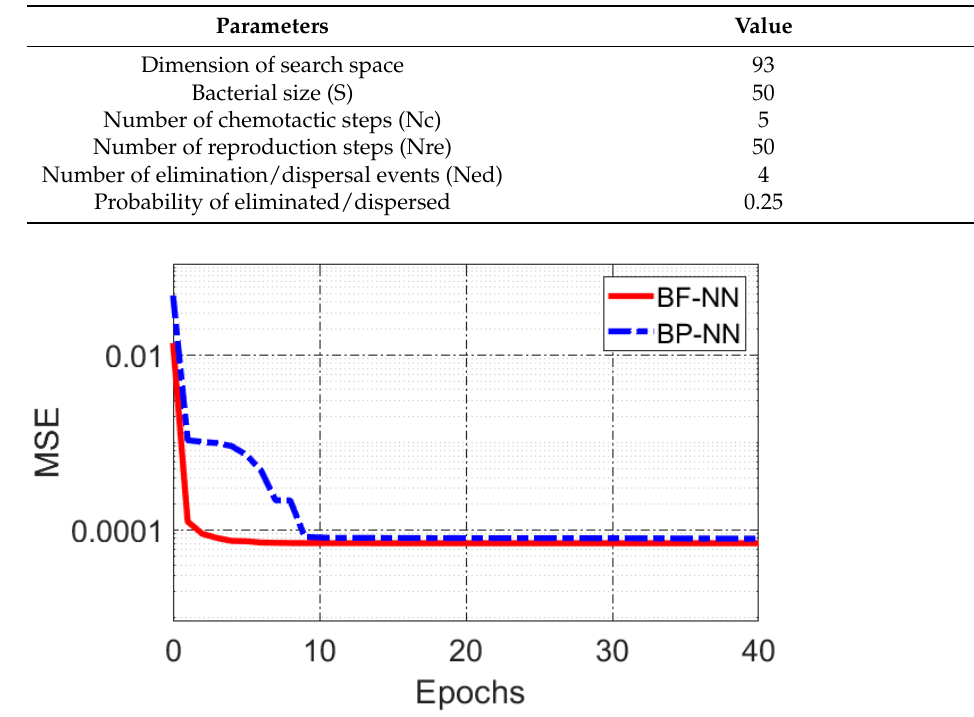
Figure 9. Training test of BP-NN vs. BF-NN. Table 3. Parameters of BF-NN algorithm.